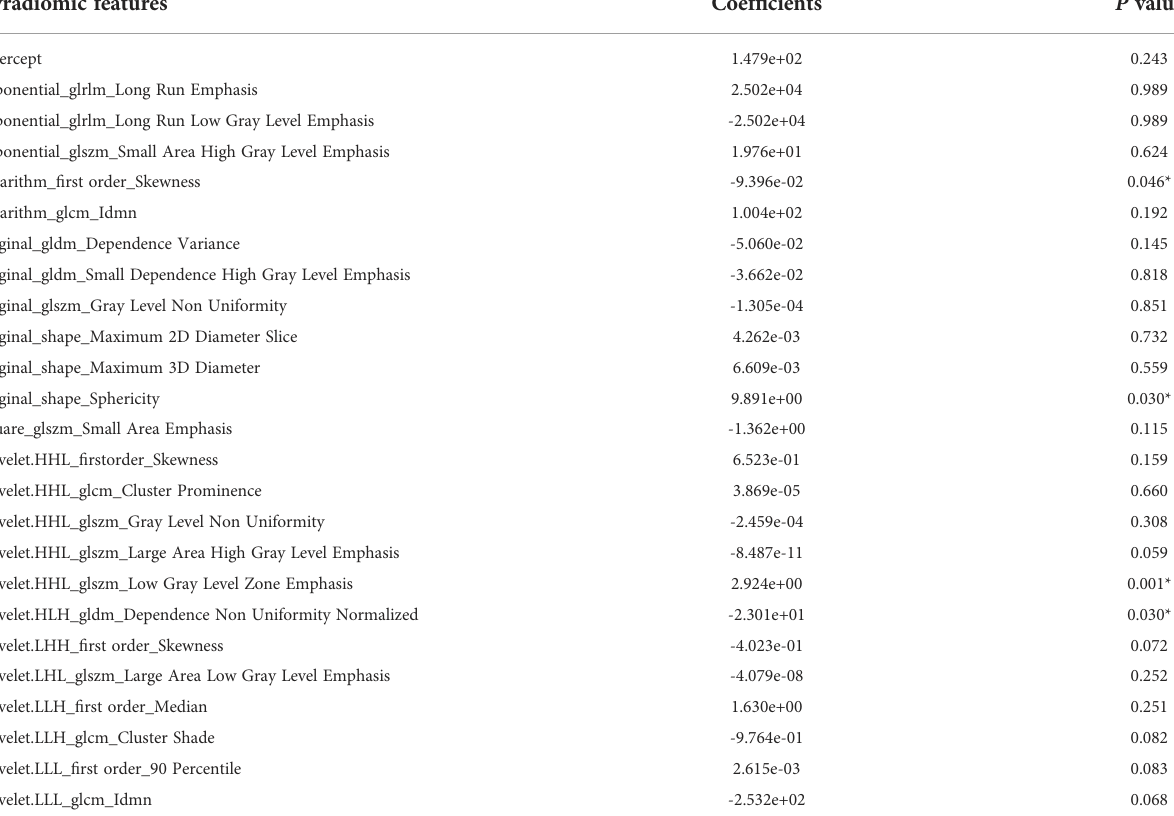
TABLE 2 Formula for calculating pyradiomics